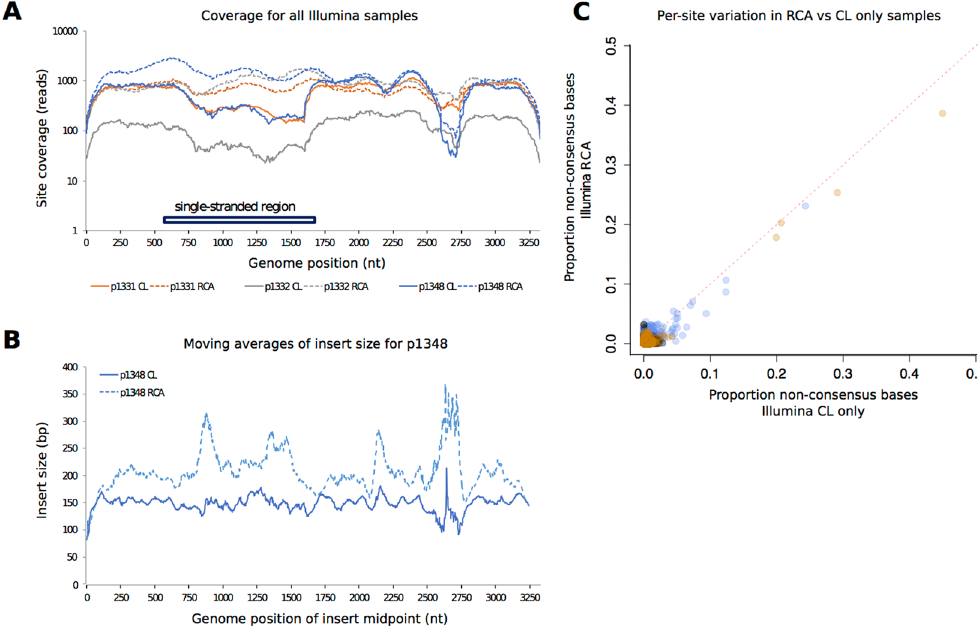
Figure 2. Comparison between HBV sequence coverage and diversity in Illumina sequences generated by completion/ligation (CL) alone, versus CL followed by Phi 29 rolling circle amplification (RCA). ( A ) Read depth across the length of the HBV genome for samples 1331, 1332 and 1348 by CL alone (solid lines) and by CL + RCA (dashed lines); ( B ) Average insert size across the HBV genome for sample 1348; ( C ) Variation detected in sequences based on CL alone, vs. CL + RCA. Each point represents a genome position with read depth > 100. For each of these positions, variation is measured as the proportion of non-consensus base calls, and plotted for both sample types. The red dotted line indicates y = x. In all plots points are coloured by patient as follows: 1331 = orange, 1332 = grey, 1348 =